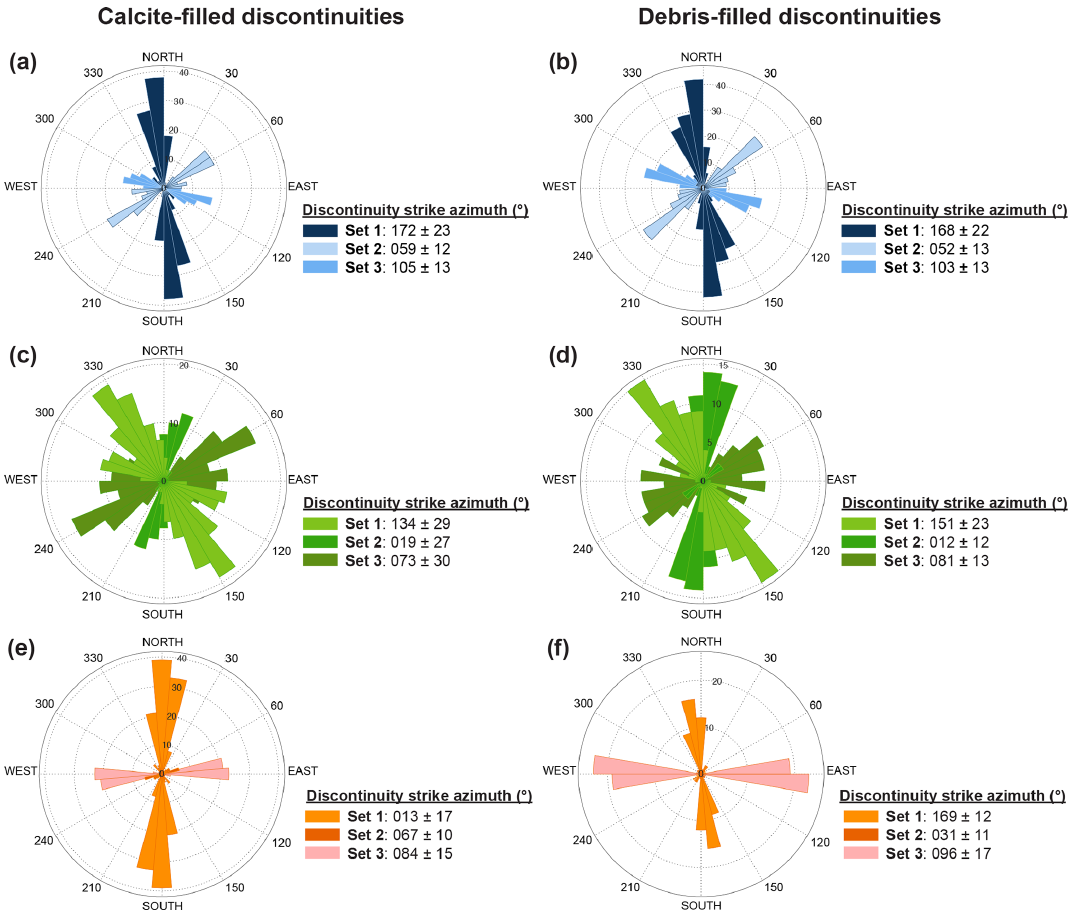
Figure 7. Rose diagrams of measured discontinuity sets at the quarries (a, b) Wuppertal, (c, d) Hagen-Hohenlimburg, and (e, f) Hönnetal as a function of their discontinuity filling, i.e. whether the discontinuities are filled with (a, c, e) calcite or (b, d, f) debris. The discontinuity strike azimuths given next to the figures correspond to the arithmetic mean values and the corresponding standard deviations.